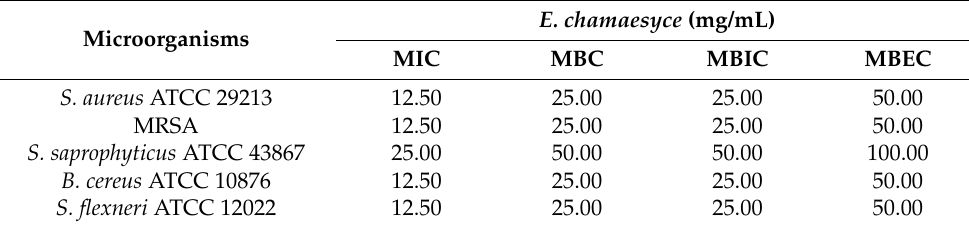
Table 3. MIC, MBC, MBIC, and MBEC results of E. chamaesyce extract.